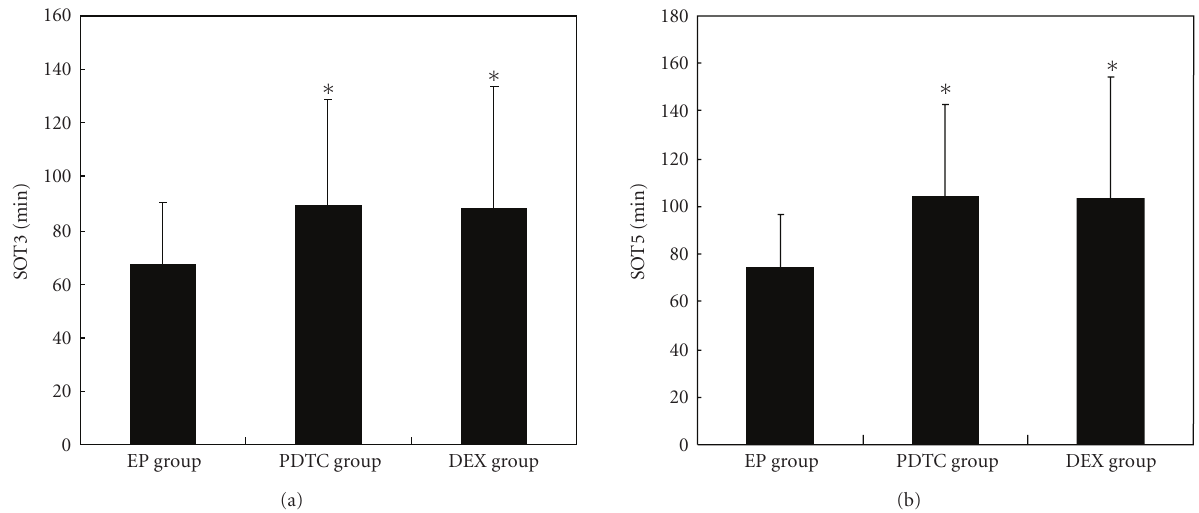
Figure 1: PDTC and DEX pretreatment prolonged the seizure onset time in KA induced rats. Mean values for the seizure onset time to grade III (SOT3, A) and grade V (SOT5, B) as the latencies to seizure of each group. SOT3 in the PDTC and DEX pretreated groups was 89 . 58 ± 39 . 28 min and 87 . 92 ± 45 . 80 min, respectively, compared to 67 . 50 ± 22 . 91 min in EP group. SOT5 in the PDTC and DEX pretreated groups was 104 . 17 ± 39 . 07 min and 103 . 33 ± 51 . 27 min, respectively, compared to 74 . 58 ± 22 . 10 min in EP group. ( ∗ P < . 05, versus EP group).